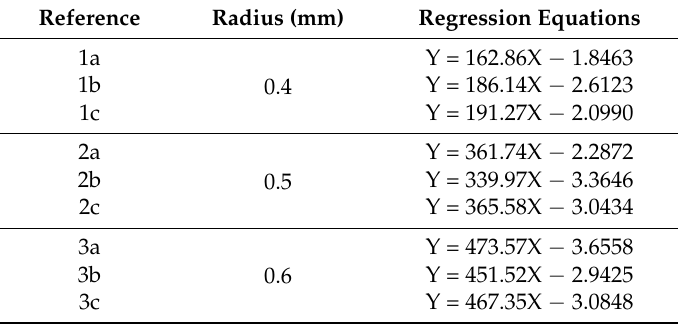
Table 3. Linear regression equations for H/W = 2.